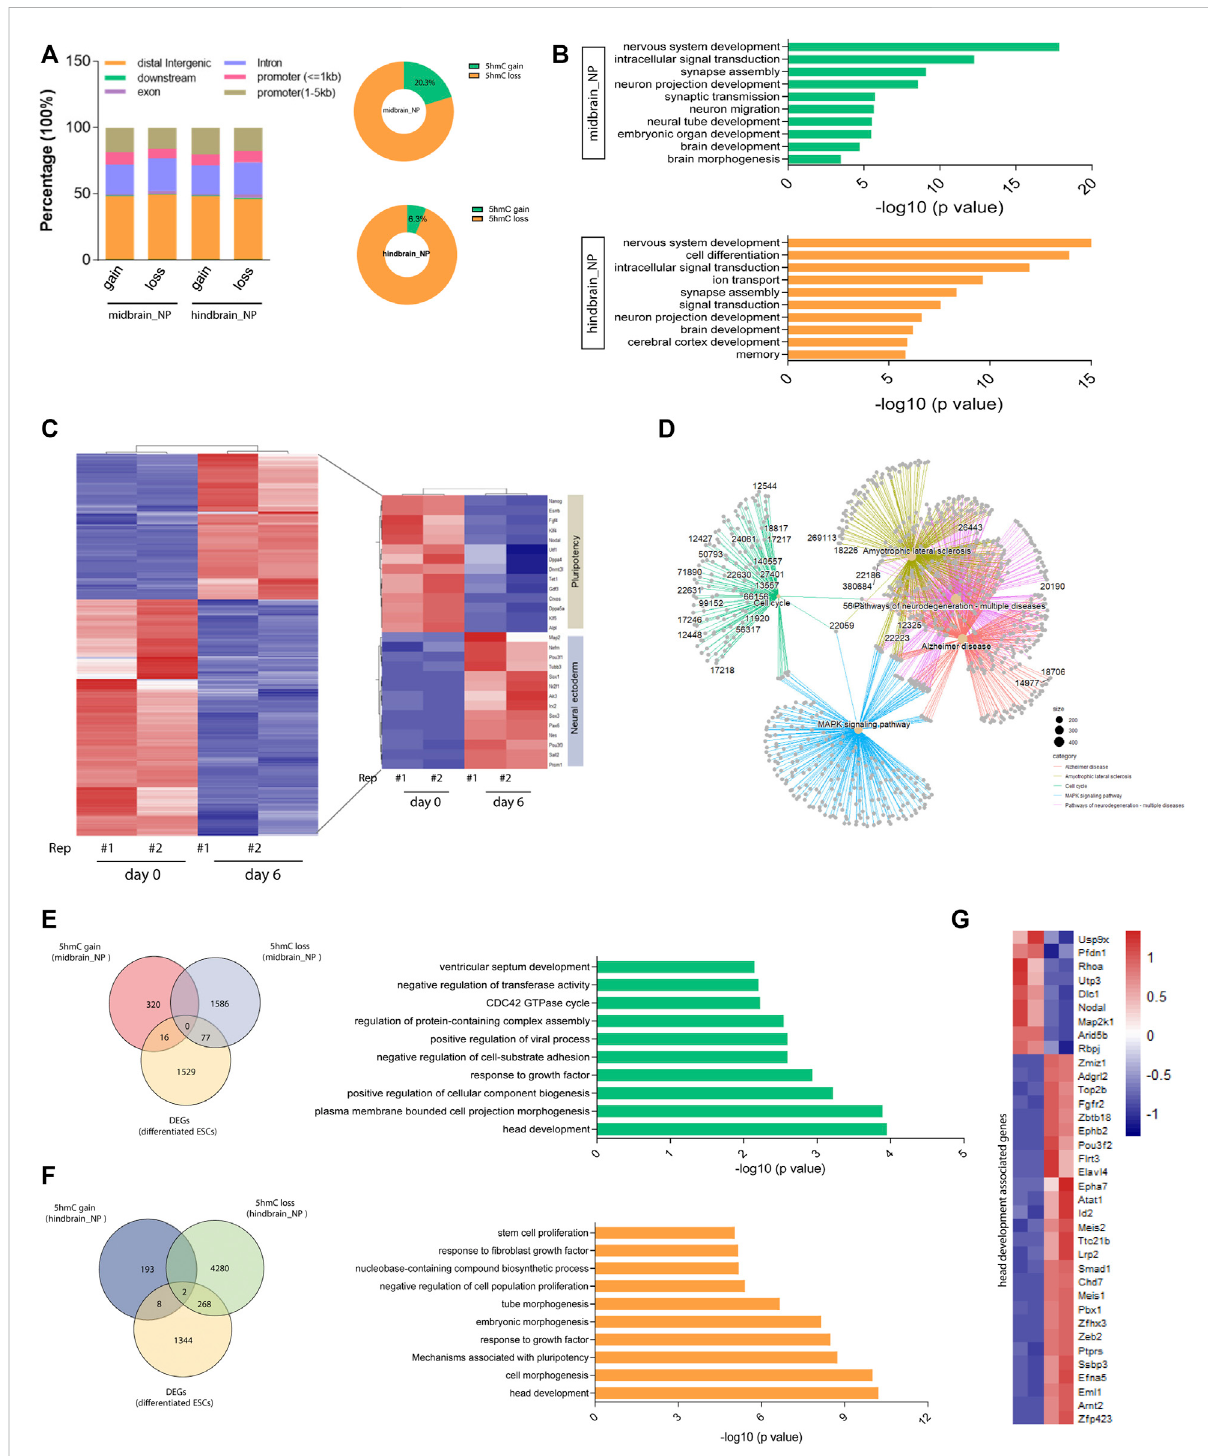
FIGURE 3 Differentially hydroxymethylated regions (DhMRs) associated with neural differentiation. (A) Genomic distribution of identi fi ed DhMRs in the differentiation of midbrain and hindbrain speci fi cation. (B) Gene ontology analysis for the DhMRs in the two progenitors, upper for the midbrain progenitors and lower for the hindbrain progenitors. (C) Hierarchical clustering of differentially expressed genes in mouse ESC at day 6 after neural differentiation. (D) Networkplotofenrichedtermscoloredbyclusteridentity. (E) DhMRsidenti fi edinthemidbrainprogenitorswereoverlapped with DEGs in the Venn diagram (left). Metascape analysis of these clustered DhMRs (16 5hmC gain and 77 5hmC loss) (right). (F) DhMRs identi fi ed in thehindbrain progenitorswereoverlapped with DEGsintheVenndiagram(left). Metascape analysis ofthese clustered DhMRs (eight5hmC gain and 268 5hmC loss) (right). (G) Hierarchical clustering of genes associated with head